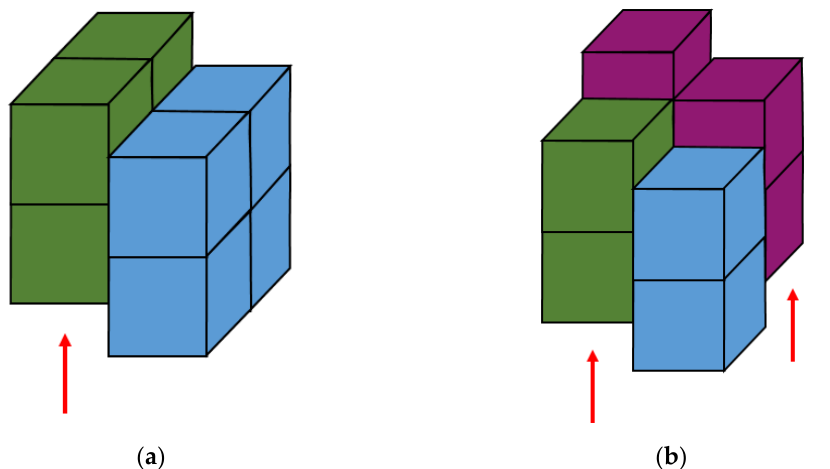
Figure 6. Boundary conditions with displacements in three-dimensional space: ( a ) one displacement, ( b ) two displacements along the one